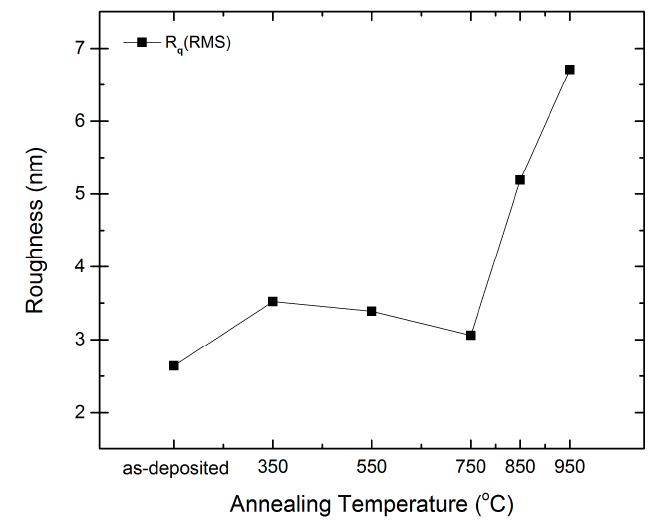
Figure 4. Surface roughness of the as-deposited and annealed ZnO:Zr thin films grown on Si (100).